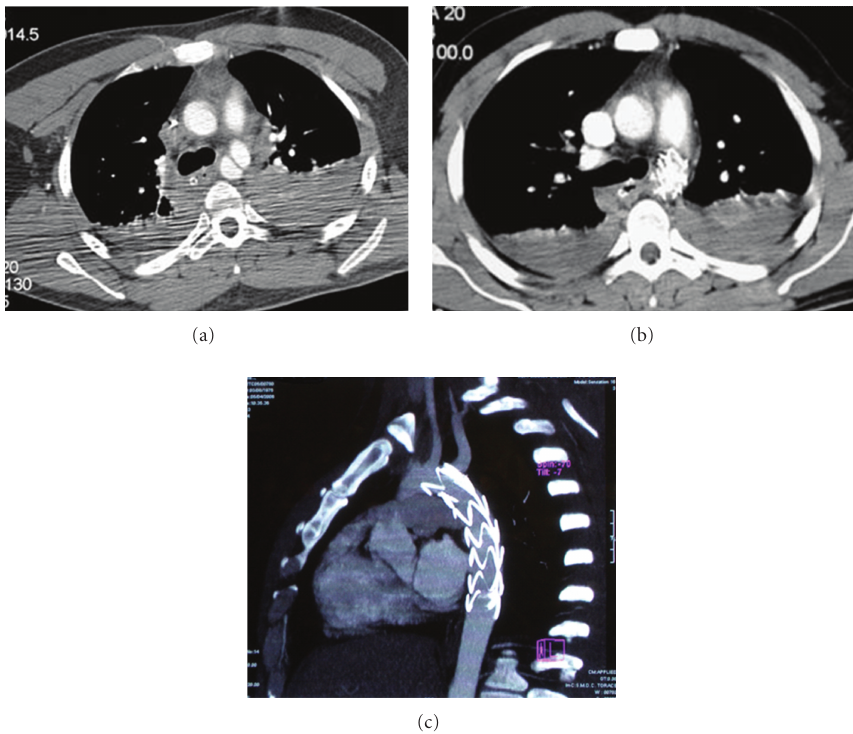
Figure 1: 24 y. Patient-motorcycle accident. (a) Preoperative CT scan. (b) Postoperative CT scan. (c) CT scan control at 7